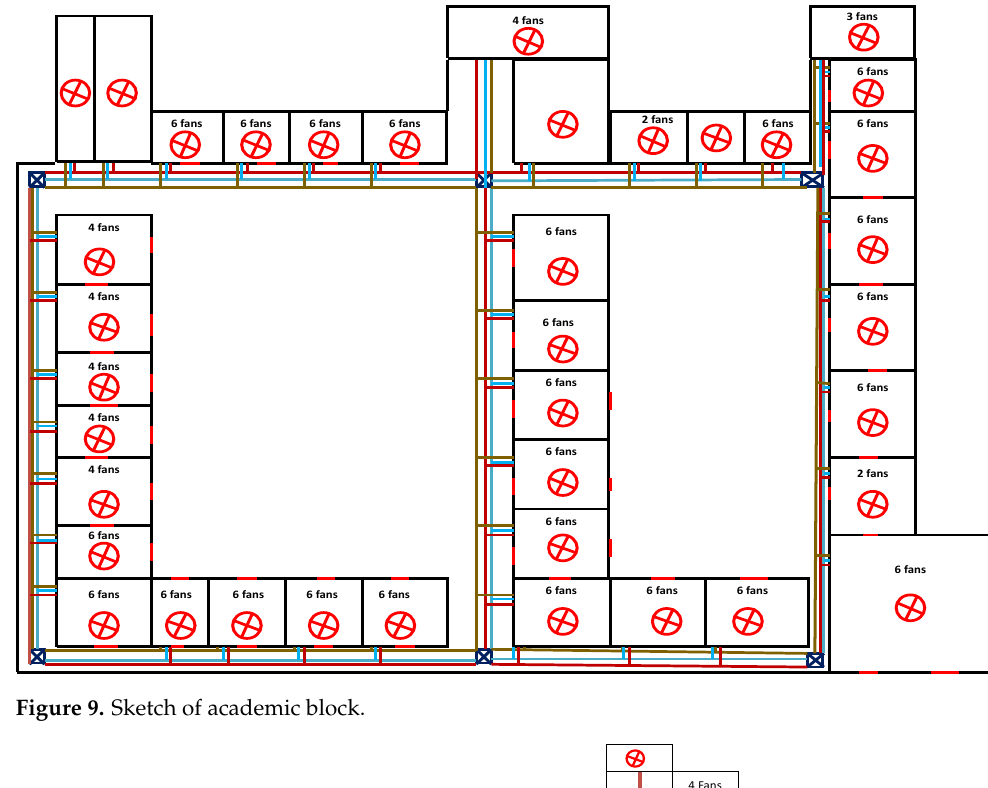
Figure 9. Sketch of academic block.